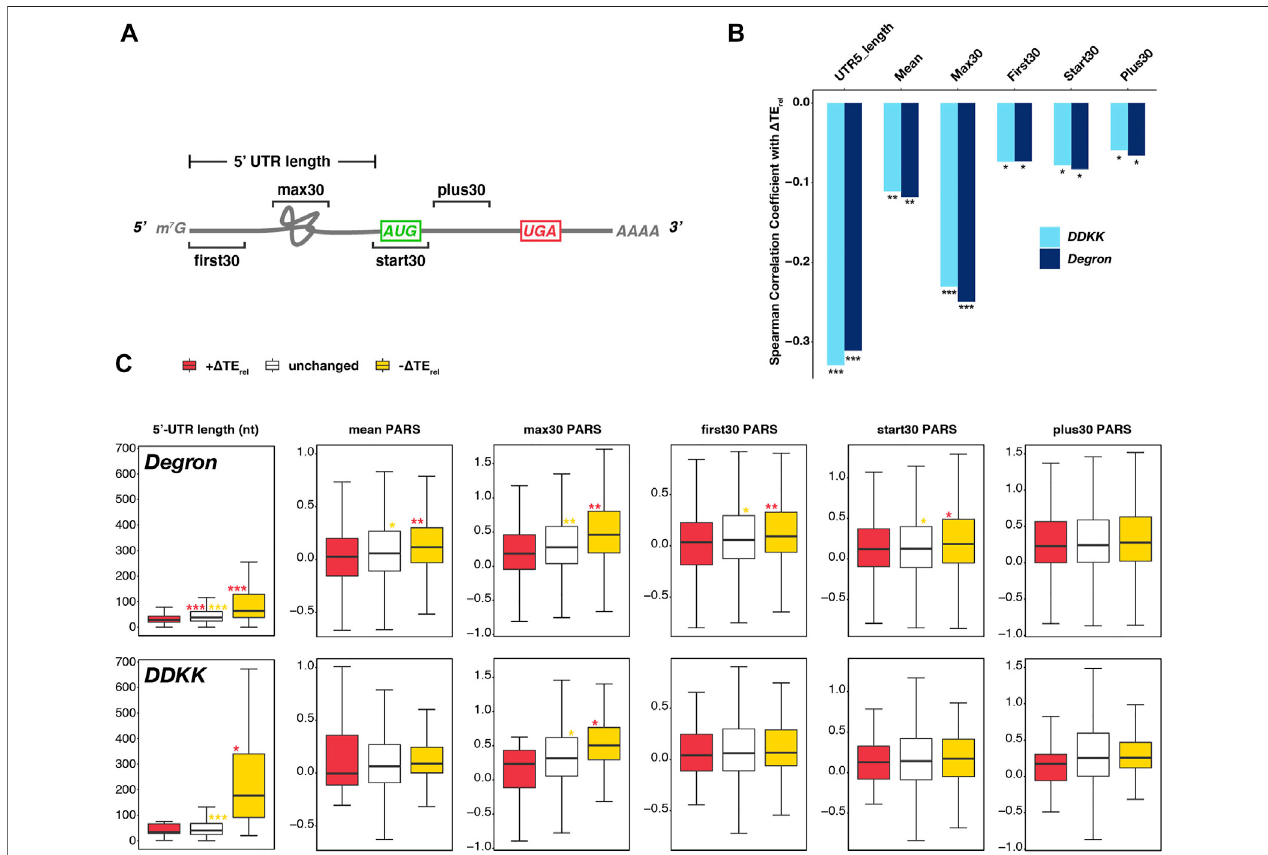
FIGURE 2 | Transcripts most sensitive to disruption of the eIF3 complex or its mRNA-entry-channel arm possess longer 5 ′ -UTRs. (A) Cartoon depicting a hypotheticalmRNAanddetailingthe5 ′ -UTRlengthandthespeci fi c30-ntwindowswithinwhichmeanPARSvalues(Kerteszetal.,2010)werecalculatedasmeasuresof structural complexity. (B) Bar plot comparing the Spearman correlation coef fi cients obtained when comparing observed Δ TE rel values in each mutant eIF3 strain and different measures of 5 ′ -UTR length or complexity. *** (cid:1) P < 10 − 10 , ** (cid:1) P < 10 − 5 , * (cid:1) P < 0.05. (C) Box and whisker plots comparing different measures of 5 ′ -UTR length or complexity between mRNAs whose TE rel signi fi cantly increases (red), decreases (yellow), or is not signi fi cantly changed (white) in eIF3a/b Degron (top row) or eIF3iDDKK (bottomrow)cells.*** (cid:1) P adj < 10 − 10 ,** (cid:1) P adj < 10 − 5 ,* (cid:1) P adj < 0.05,colorindicatescomparisonset;WilcoxonTestfor5 ′ -UTRlengths,ANOVAwithpost-hoc Tukey test for